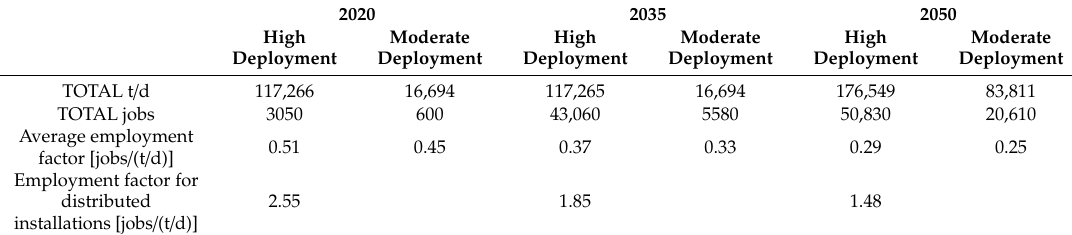
Table 6. Employment factors estimation (own elaboration from